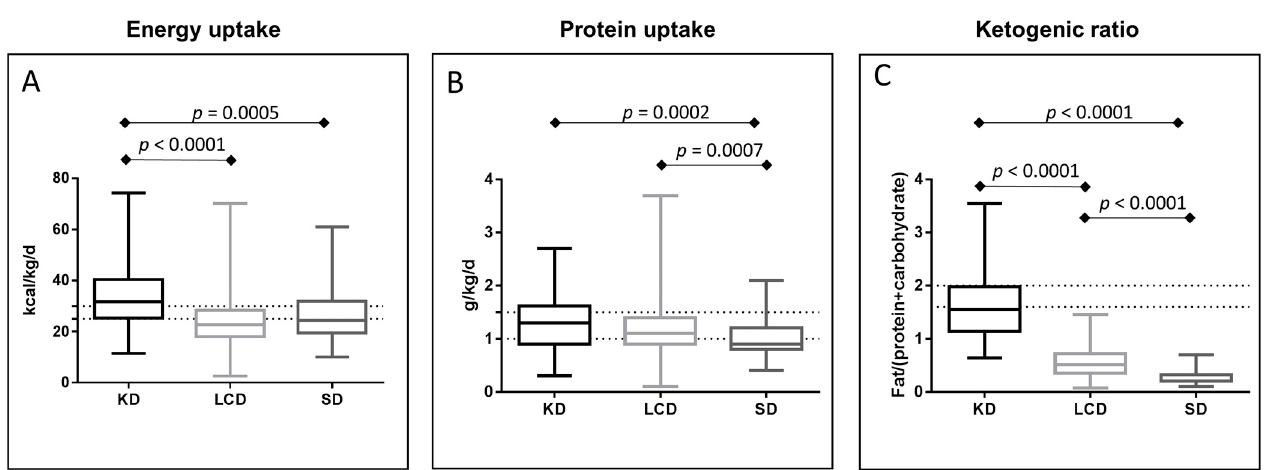
Figure 2. Diet analysis. Energy intake ( A ), dashed lines: optimal daily energy intake (25–30 kcal/kg/d) as recommended for ambulatory patients [31]; protein intake ( B ), dashed lines: goal for daily protein intake in cancer treatment (1–1.5 g/kg/day) according to [31]; and ketogenic ratio ( C ), defined as the amount of fat divided by the sum of protein and carbohydrates, dashed lines: goal in the study 1.6–2.1.